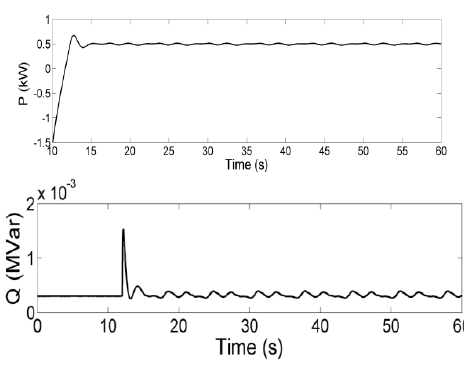
Figure 20. Battery Inverter active and reactive power